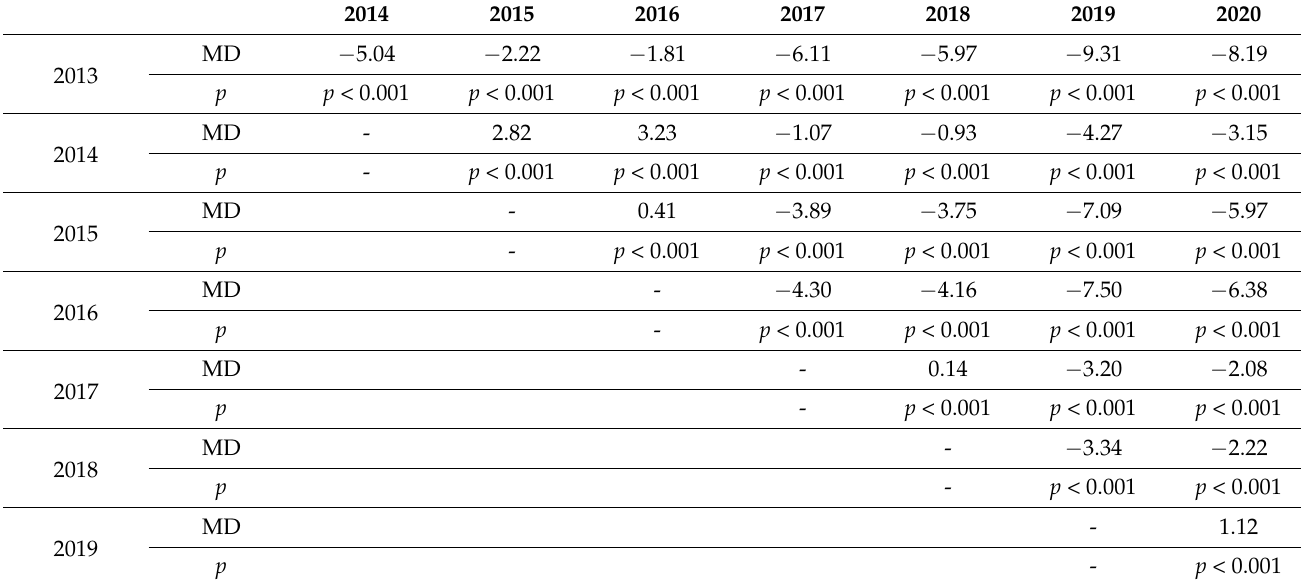
Table 11. Comparison of the earlier preparation of adrenaline between individual editions of the